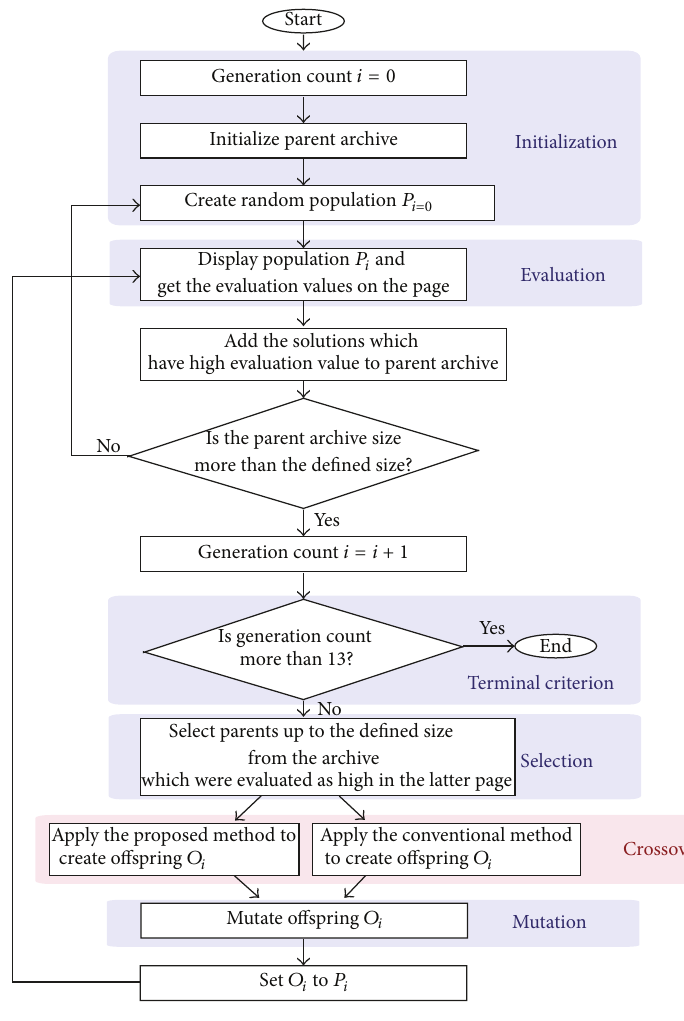
Figure 6: Flowchart of experimental system.